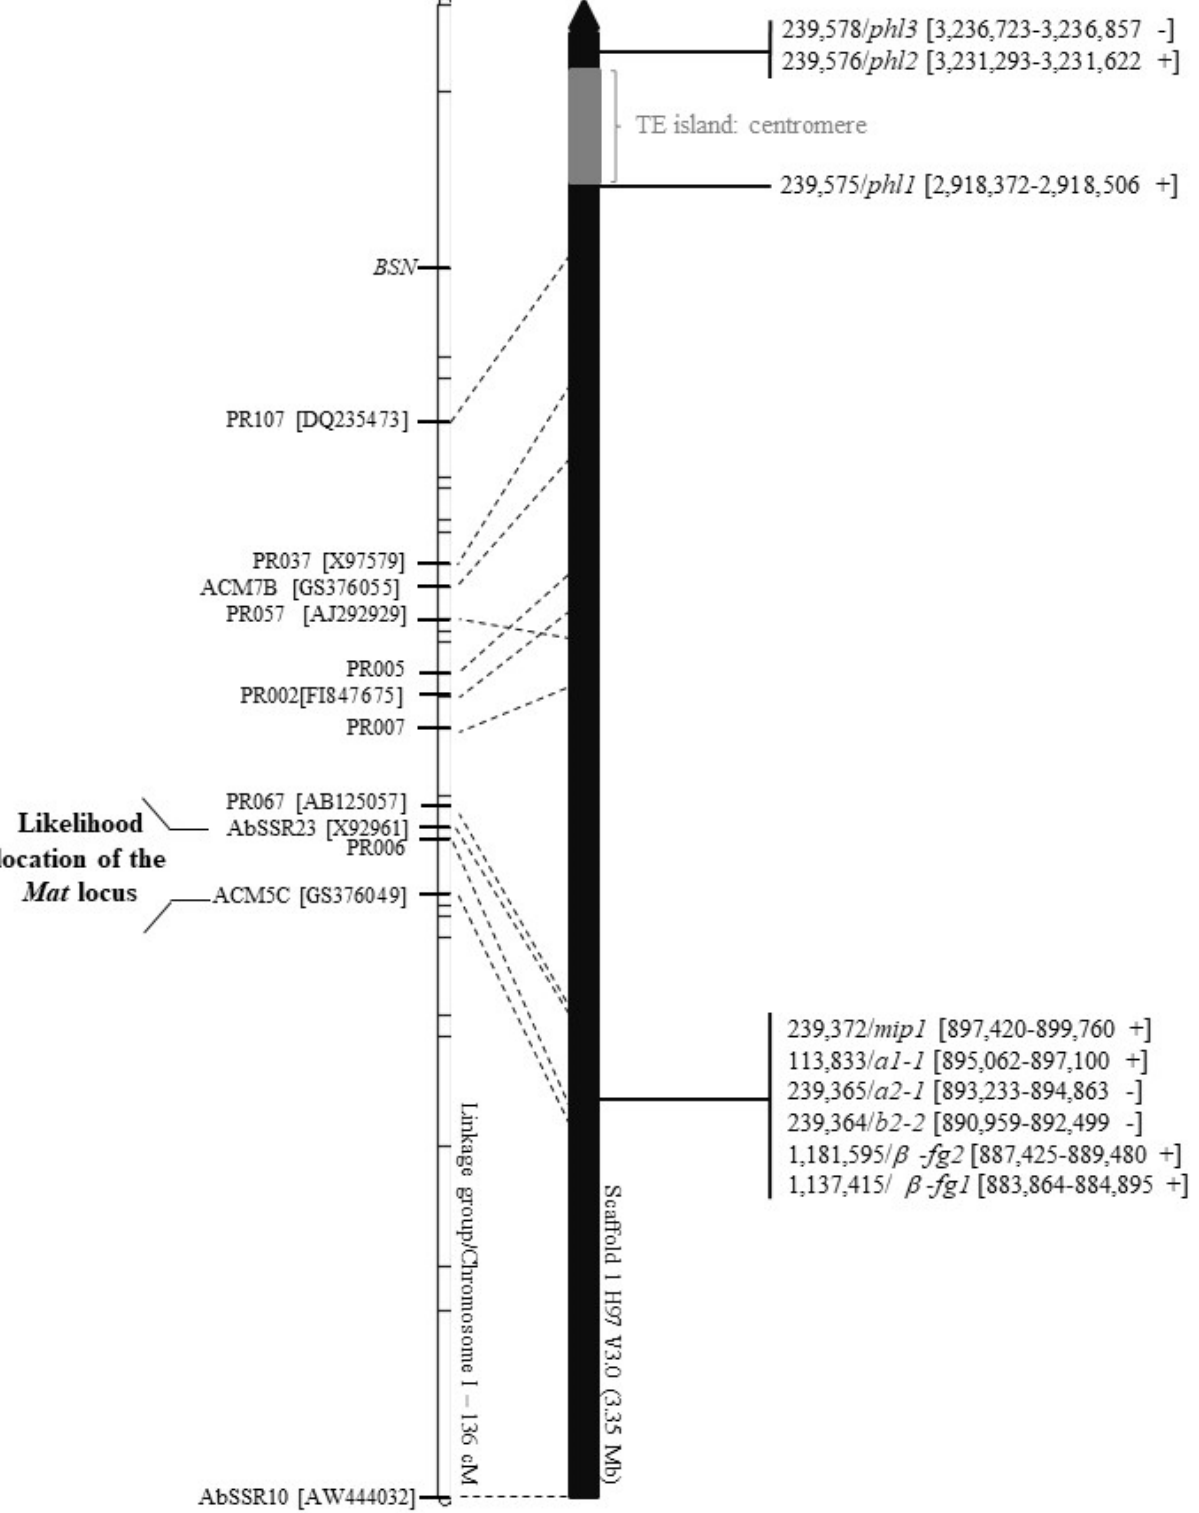
Figure 1. Mapping the mating-type ( MAT ) locus on chromosome 1 of A. bisporus var. bisporus strain H97 with genetic data on markers previously published [38,54]. Only markers that made possible to anchor the scaffold 1 sequence are located. PRxxx, ACMxx are CAPS (cleaved amplified polymorphism sequence) markers; AbSSRxx are microsatellites. When available, the GenBank reference number is given in bracket. The position of the BSN locus controlling the presence of two or four spores in basidia is also indicated.